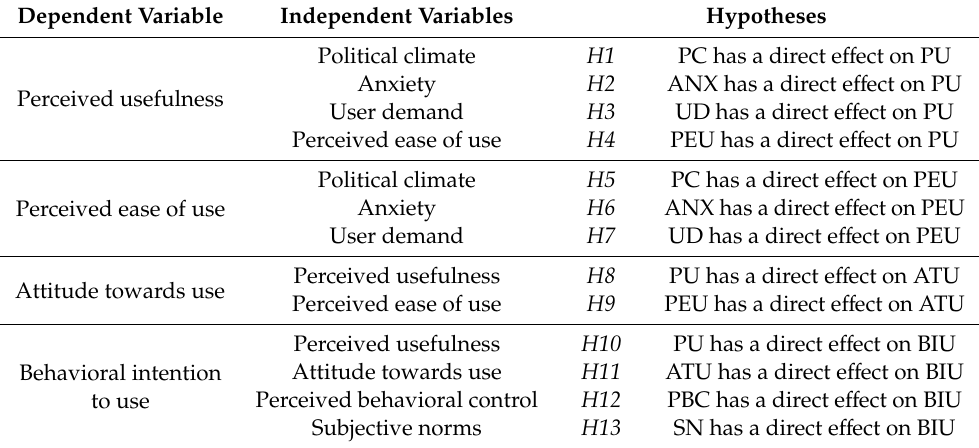
Figure 3. The combined technology acceptance model and theory of planned behavior (C-TAM-TPB) research framework adopted from the study of Ignacio et al. [19]. Table 2. Research variables and hypotheses .